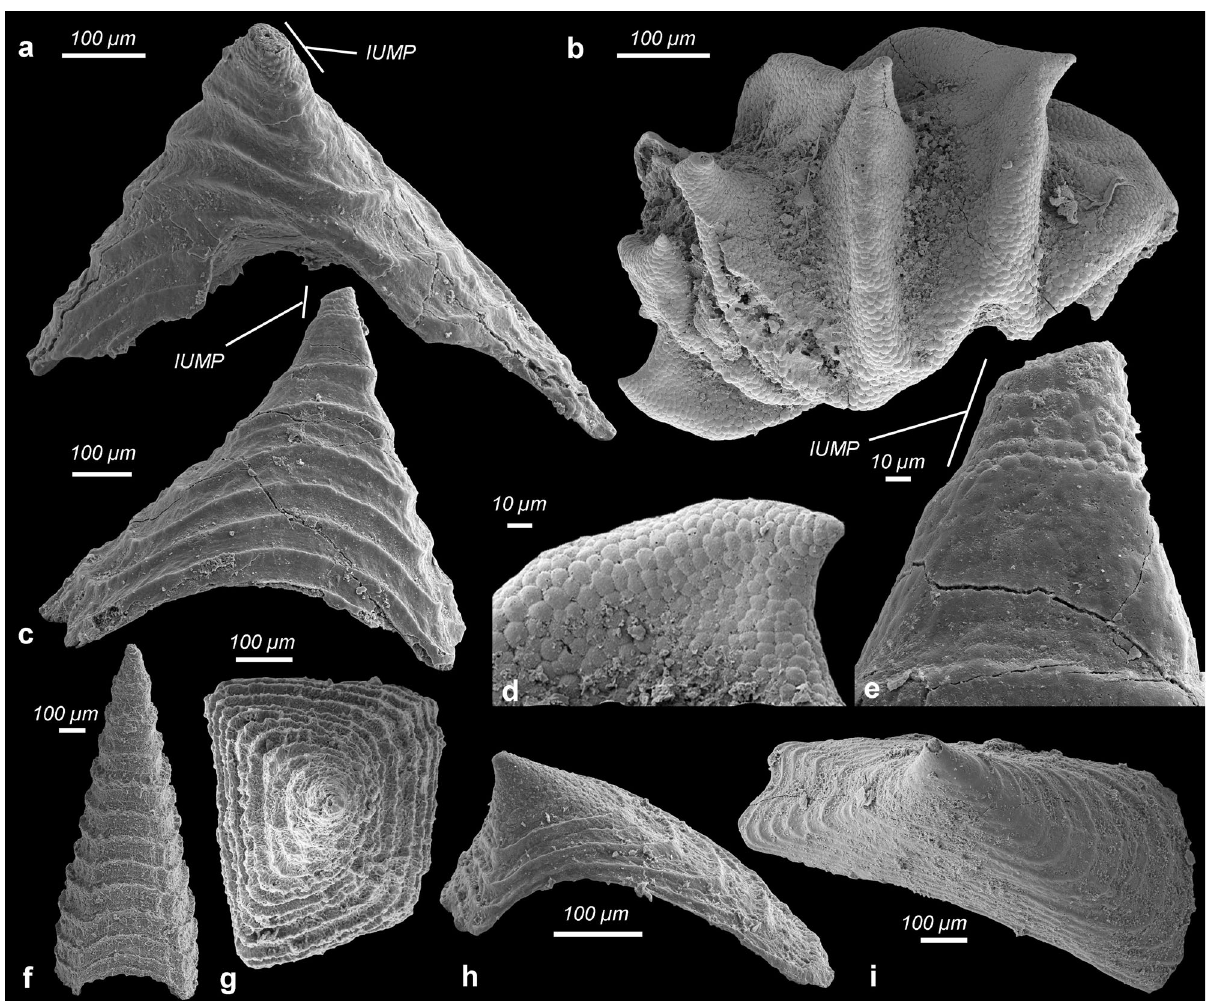
Fig. 5 Camenellan juvenile and disarticulated tommotiid sclerites from the Cambrian Salanygol Formation of Mongolia. a , c Anterior and posterior views of disarticulated saddle-shaped sclerites of C. mongolica co-occurring with camenellan juvenile; note the partly broken tip preserves cellular pattern only visible in the juvenile part, but not in biomineralized parts with co-marginal ribs. b Dorsal view of an incomplete camenellan juvenile with six central erect spinose nascent sclerites; note cellular pattern still preserved on whole dorsum. d Detail of cellular pattern in a central nascent sclerite C1 of camenellan juvenile prior to onset of biomineralization, enlargement from b . e Detail of cellular pattern in the juvenile part of C. mongolica shown in c ; note phosphate biomineralization covered cells with formation of co-marginal ribs. f Lateral view of an almost symmetrical sclerite of C. mongolica . g Apical view of f . h Lateral view of an asymmetrical sclerite of C. mongolica and four co-marginal ridges. i Oblique view of an almost symmetrical sclerite of C. mongolica with a central fold ( “ sella ” ). All images are electron microscope micrographs. IUMP initial primarily unbiomineralized part of the early postembryonic developmental stage of Camenella . Specimen identi fi ers: a , c , e Sal 133-023; b , d Sal 134-05; f , g Sal 121-10; h Sal 133-10; i Sal